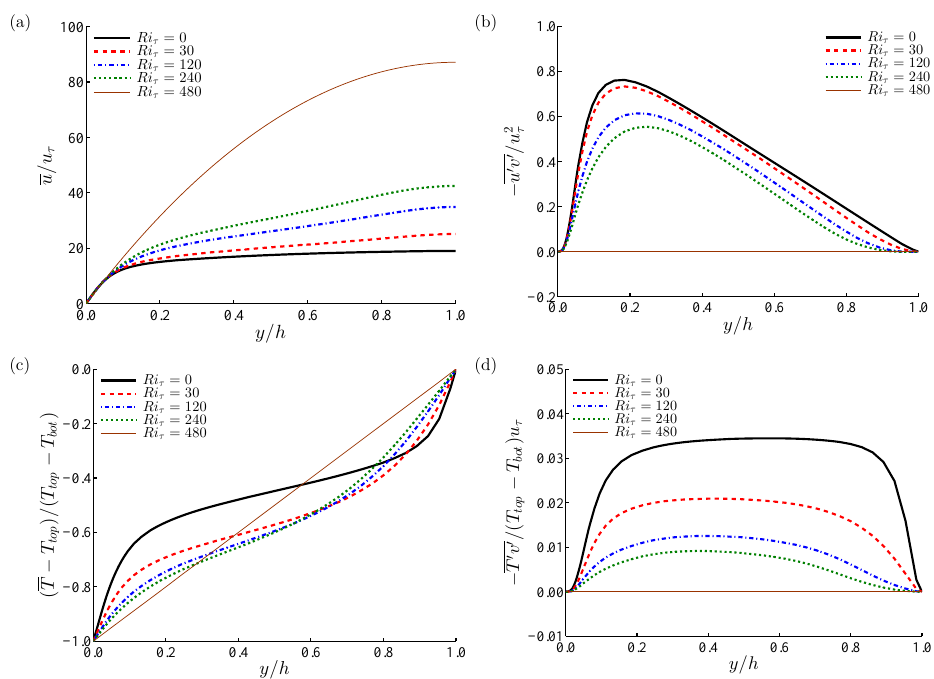
Figure 3. Vertical distributions of variables with different Ri τ ( Re τ = 180). (a) Mean streamwise velocity ( u ), (b) turbulent momentum flux ( − u (cid:48) v (cid:48) ), (c) mean temperature ( T ), and (d) turbulent heat flux ( − T (cid:48) v (cid:48)